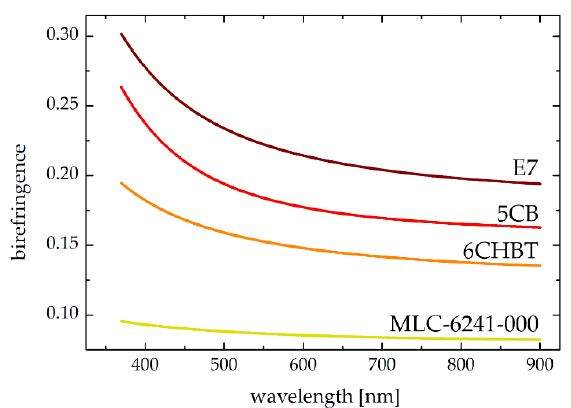
Figure 2. Birefringence dispersion for typical nematic liquid crystals and mixtures [35,38,40] assumed in numerical simulations concerning the design of holographic diffraction gratings.